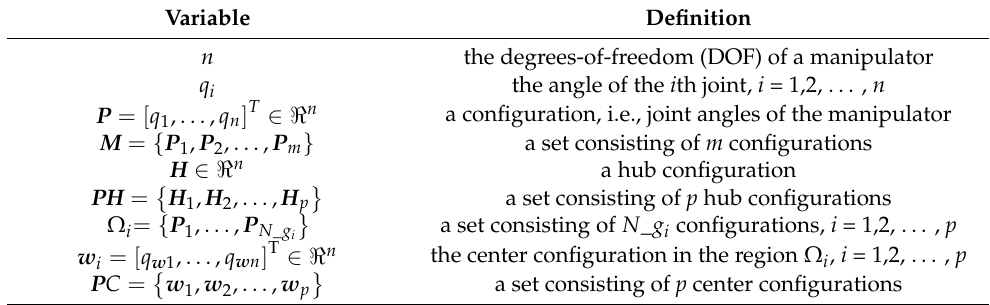
Table 1. Definitions of some